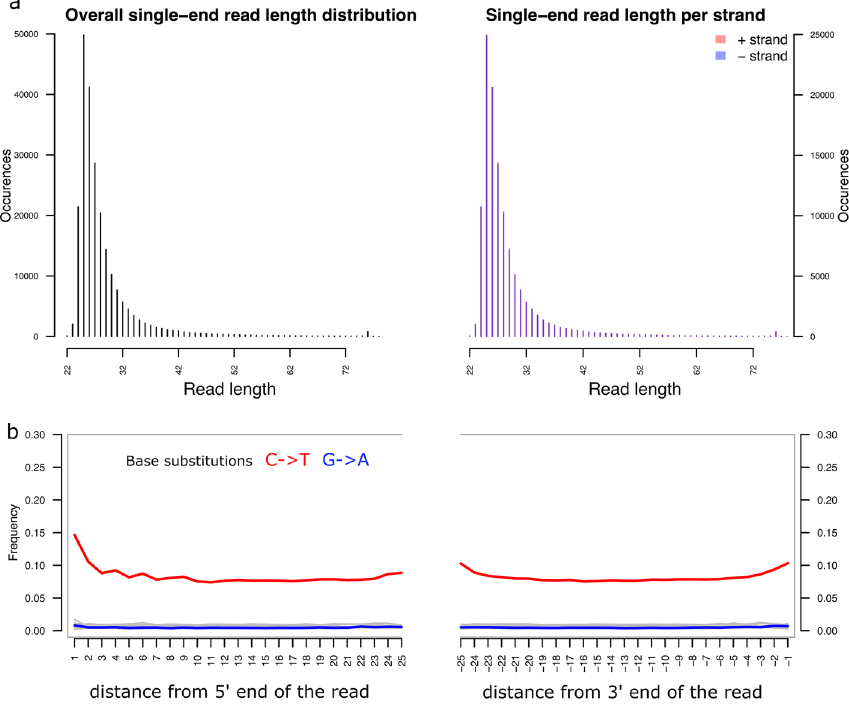
Figure 2. Characteristics of aDNA fragments from the hair sample. ( a ) Length distribution of shotgun sequencing reads mapped to the whole genome using read length filter cut-off at 25 bp in the step of adaptor removal. ( b ) High C-to-T substitution rates in the interior of aDNA